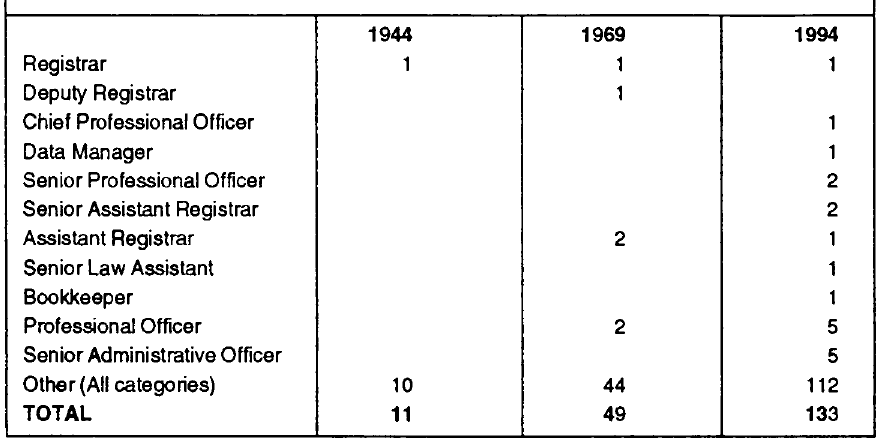
Table 2 sets out the growth in the budget of the